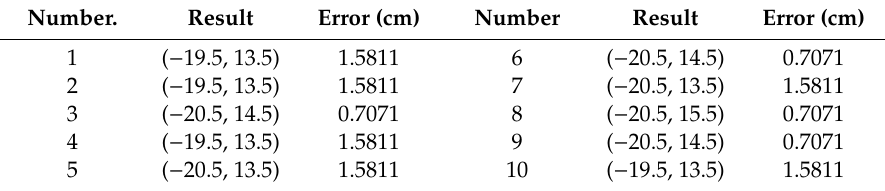
Table 2. Preliminary location result (PLRs) of 10 experiments at an impact point ( − 20, 15).